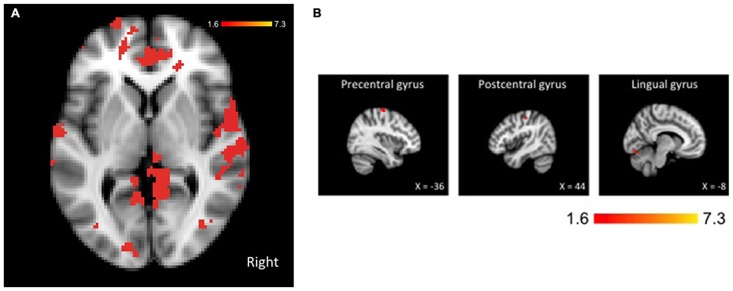
Brain activation for the dual-task > single-task contrast showing greater activation for non-fallers compared with fallers. The threshold was set at p < 0.05, presented in neurological orientation. (A) Whole brain activation shown at coordinates x = 0, y = 0, z = 0. (B) Three significant clusters with maxima in precentral, postcentral, and lingual gyri. The threshold was set at p < 0.05, presented in neurological orientation.